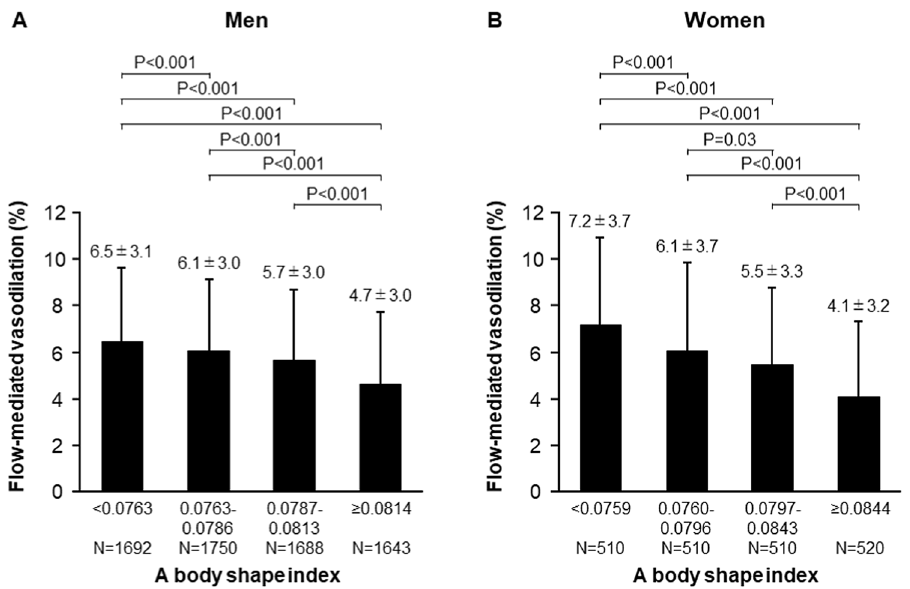
Figure 1. Bar graphs showing flow-mediated vasodilation according to a body shape index in men ( A ) and in women ( B